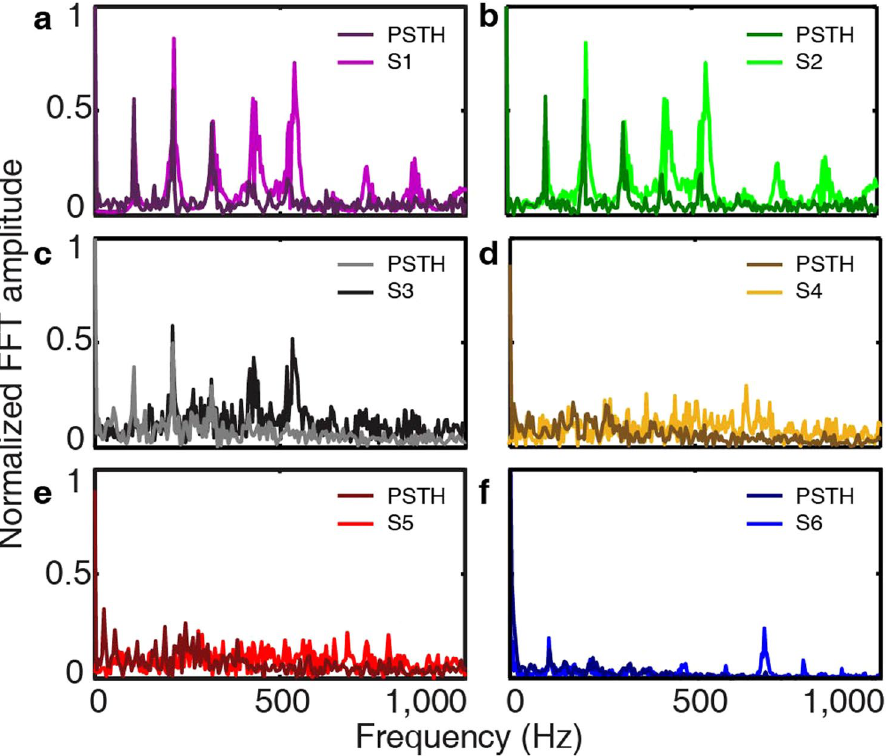
Figure 3. Spectra of the acoustic stimuli were plotted along with the spectra of their corresponding PSTHs calculated from the neural activity obtained during acoustic stimulation from one representative unit in the guinea pig ICC. The best frequency (BF) of the unit was 600 Hz. A voiced syllable “o” from “the silly boy is hiding” was selected (0.714 to 0.914 s post the onset of each sentence). S1 to S6 were shown in a to f. The magnitude of spectra was normalized to the maximal magnitude with 1000 Hz to allow a direct comparison. The first three dominating peaks in S1 (a), S2 (b) and S3 (c) were at 105, 210, 315 Hz